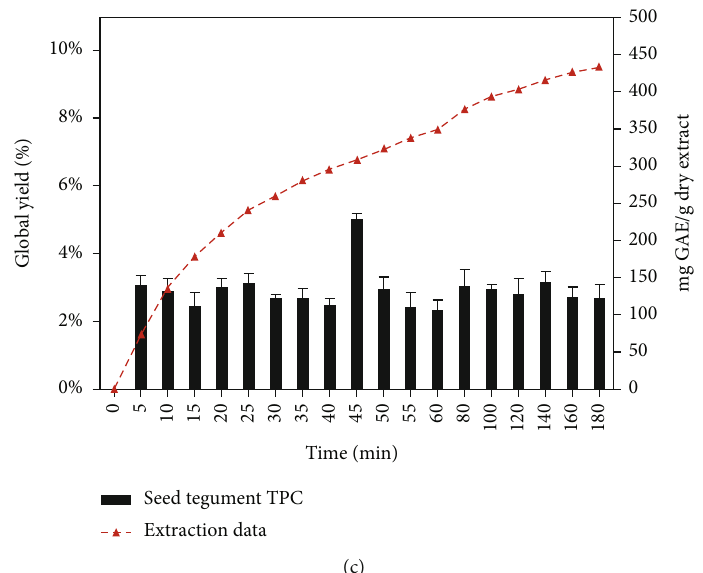
Figure 2: Kinetics of extraction, TPC, and global yield by PLE: (a) epicarp, (b) seed, and (c) seed tegument of Hass